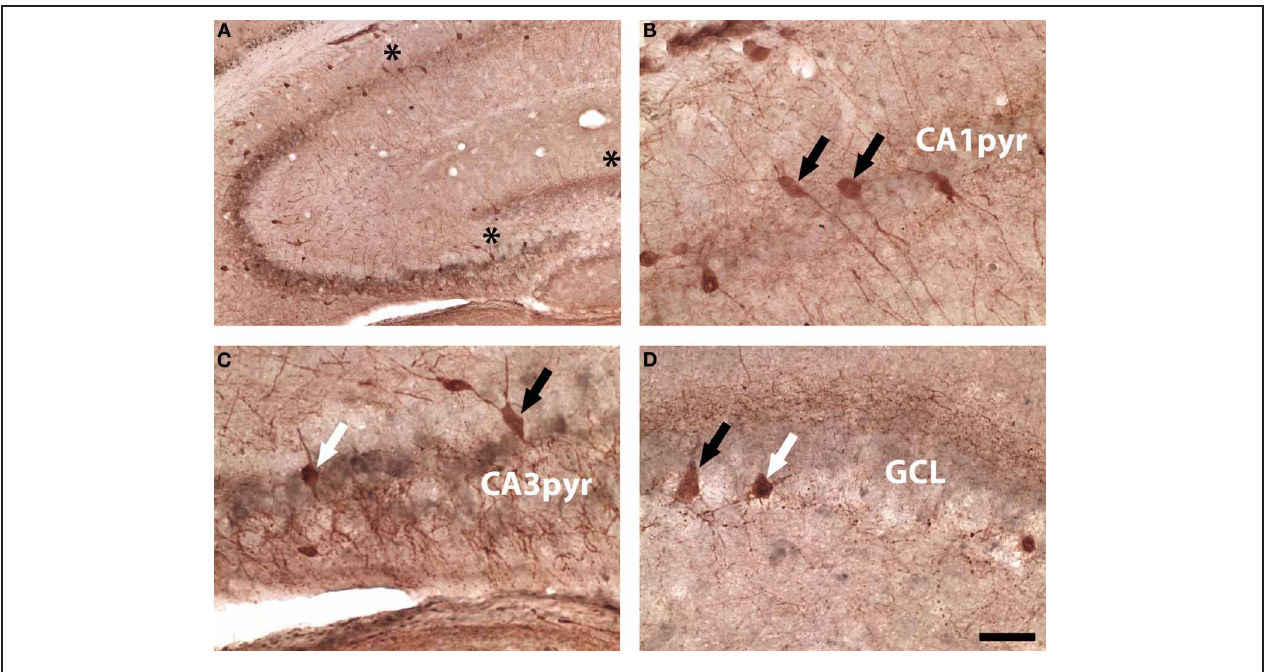
FIGURE 6 | Brightfield parvalbumin (red) and WGA (gray) labeling in a DBH-WGA mouse. (A) Low magnification image showing CA3-WGA pattern. (B) CA1 parvalbumin-only reactivity (black arrows). (C) Interneurons in CA3